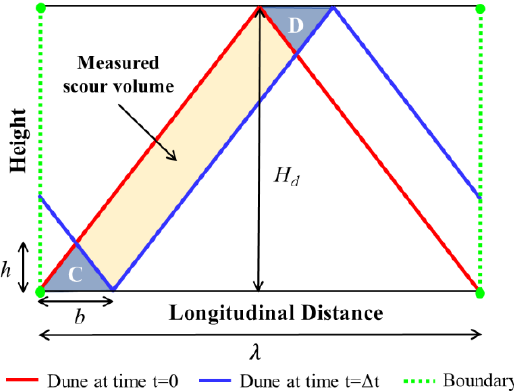
Figure 5. Schematic diagram showing the systemic bias due to the not-computed scour volumes (adapted from [15]).